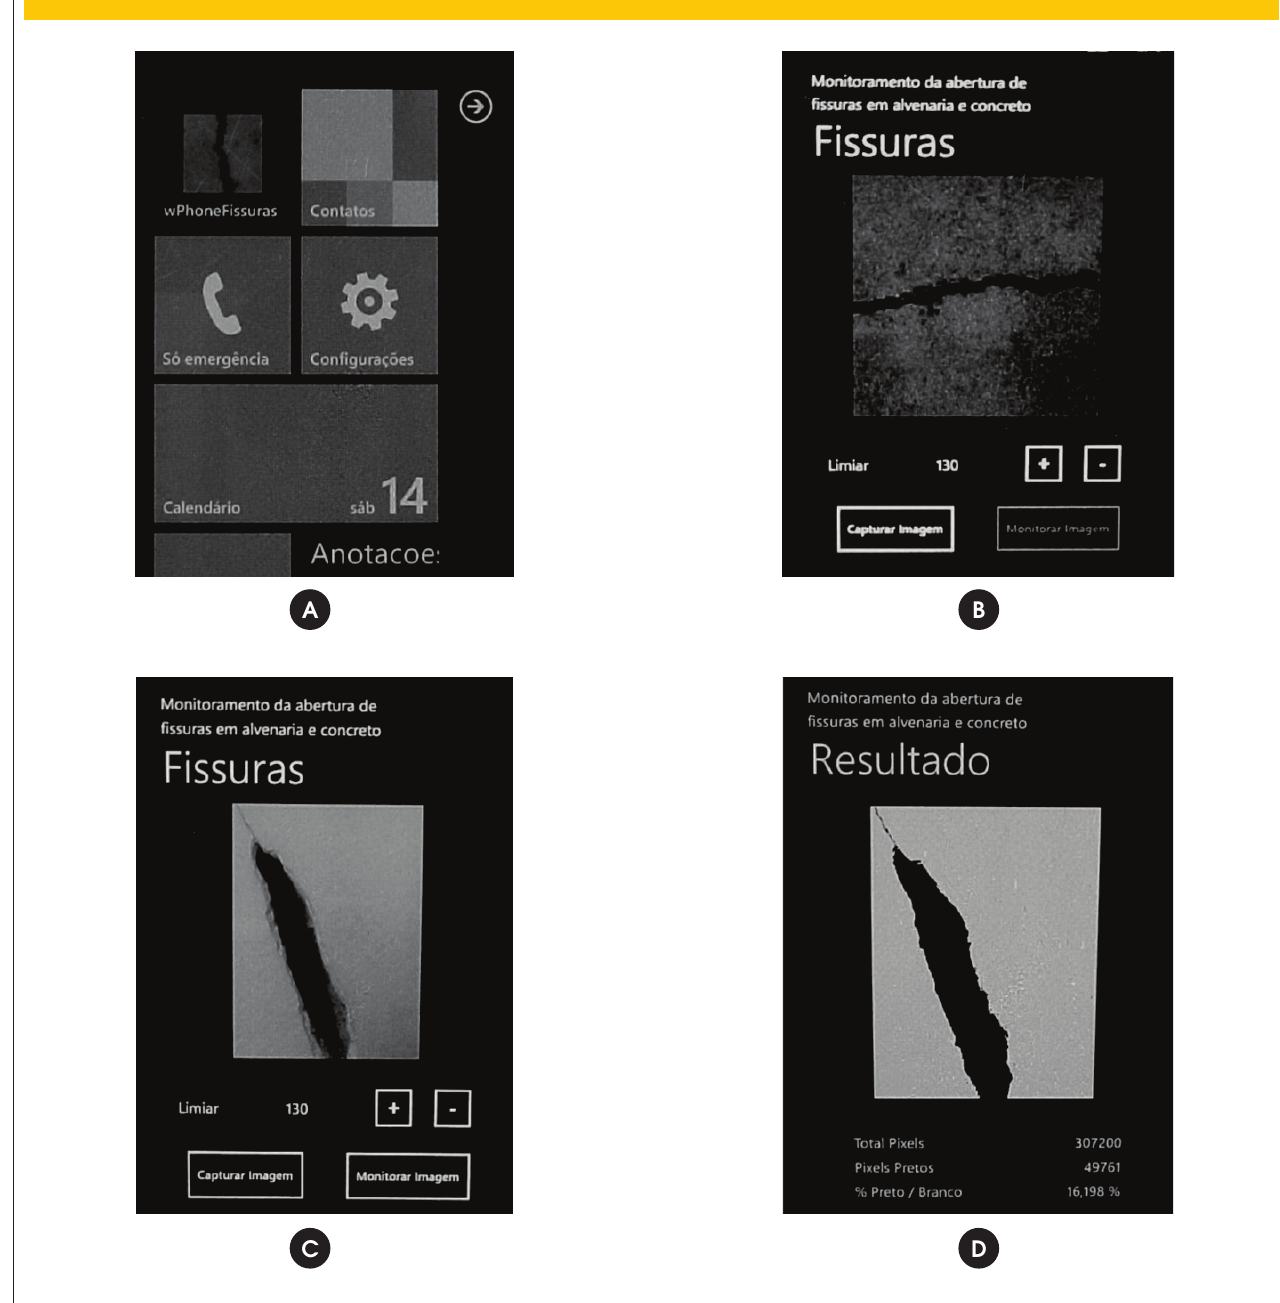
Figure 10 – Processing of an image in the mobile phone with Windows Phone System: (a) system selection of image capture to be processed (wPhoneFissuras); (b) System selection (Home screen) and of threshold to the image processing to be captured; (c) Captured image Processing (Monitoring); (d) Binary image of crack and the introduction of outcomes of monitored image